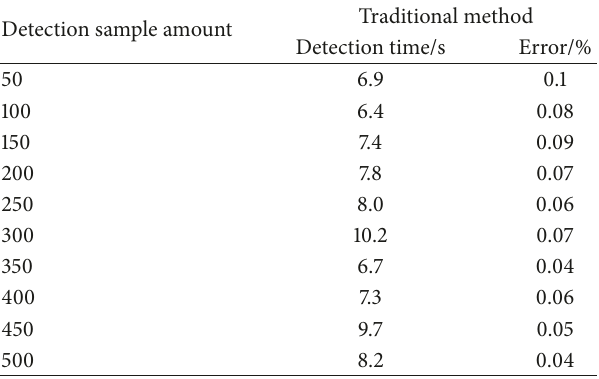
Table 4: Times and errors of outlier date feature state responses detected with the traditional method.